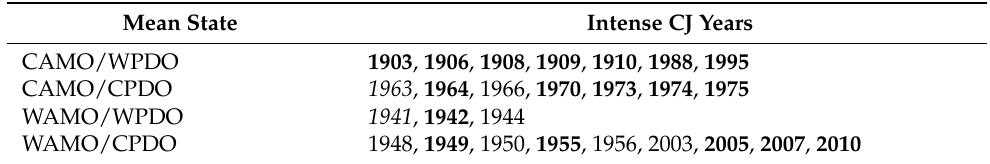
Table 1. Intense years of the Choco jet (CJ) during indicated mean states. According to the criteria of the Oceanic Niño Index (ONI) years in bold are La Niña events, italic years are El Niño events, and the remaining years are neutral